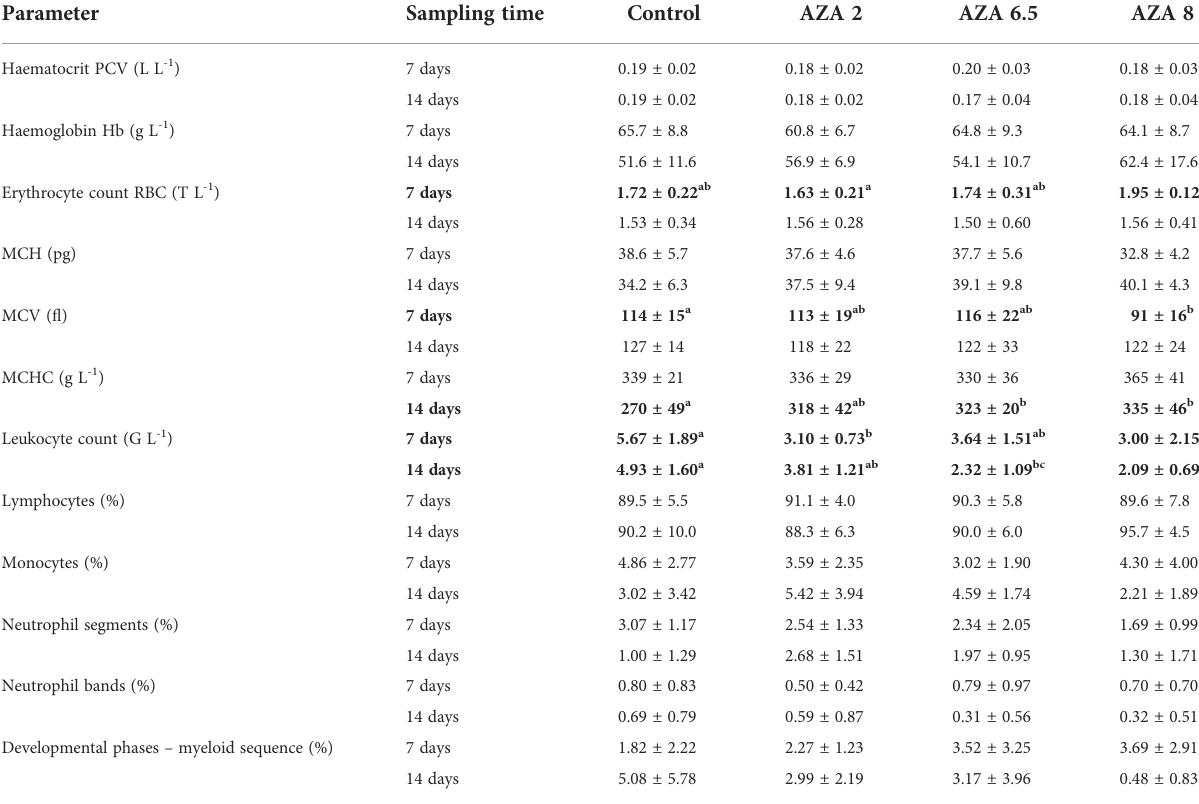
TABLE 3 Hematology values and leukogram (mean ± SD) measured from the blood of Nile tilapia kept in control and exposed to different concentrations of azadirachtin (AZA 2 µg L -1 ; AZA 6.5 µg L -1 and AZA 8 µg L -1 ) for 7 days and after recovery period (14 days). Parameter